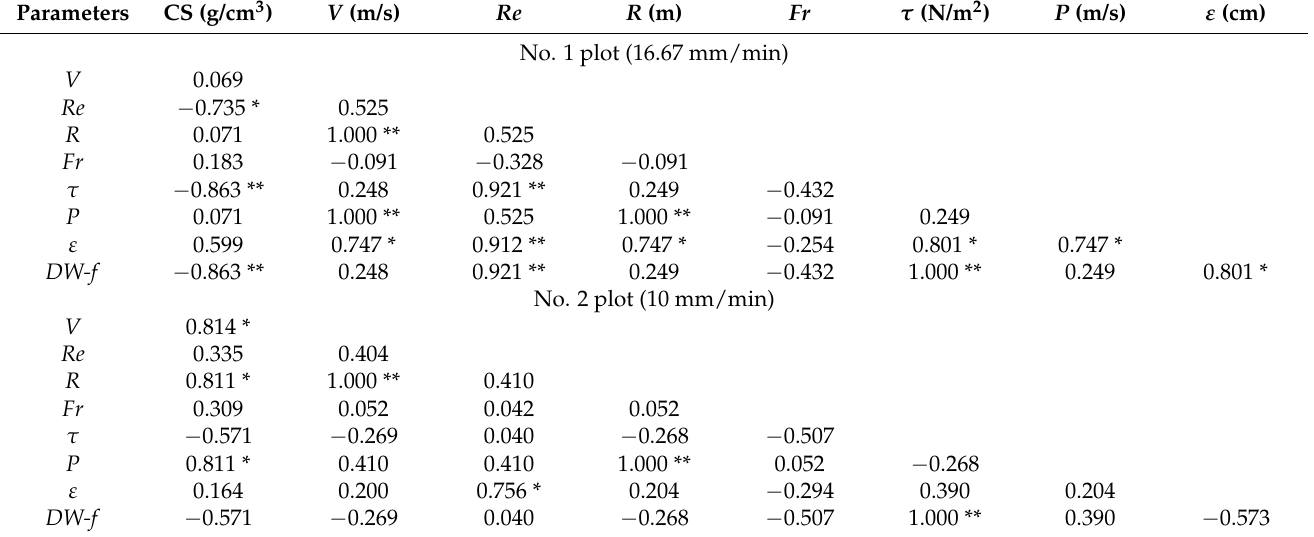
Table 1. Correlation between the mean sediment content and runoff hydraulic parameters in the two experiments.